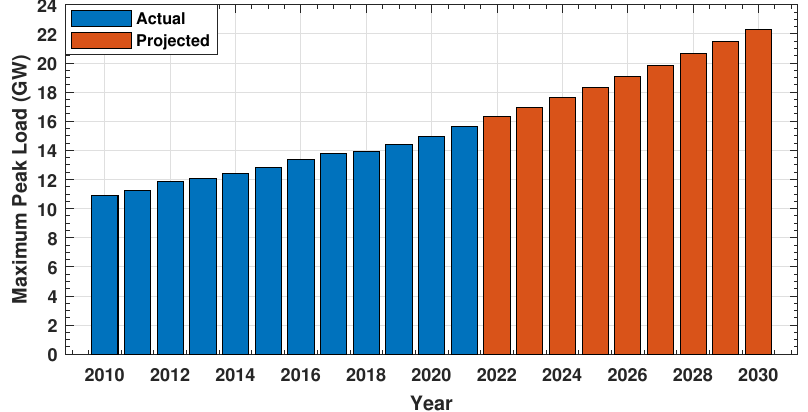
Figure 1. Actual and projected maximum peak load in